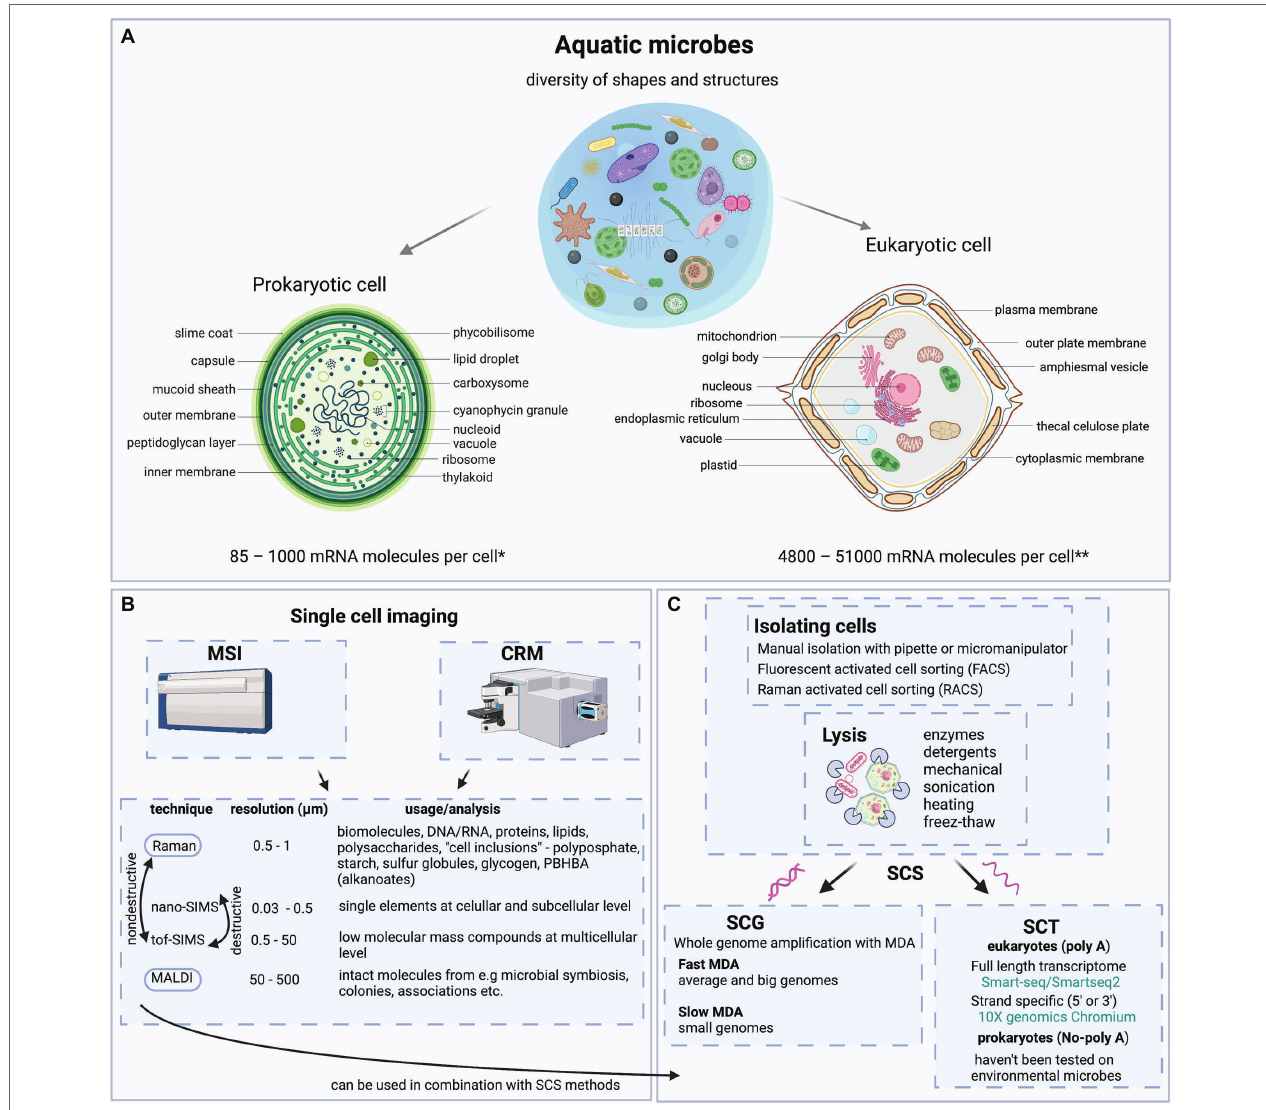
FIGURE 2 | Overview of Aquatic Microbes, MSI and SCS workflows in Aquatic Microbiology. (A) Diversity of shapes and structure present in aquatic microbial cells. Prokaryotic cell architecture is illustrated using unicellular cyanobacteria as an example. Eukaryotic cell architecture is illustrated using a thecate non-flagellated dinoflagellate example. Amounts of mRNA in prokaryotes and eukaryotes are based on estimates. * Based on RNA recovery from natural bacterioplankton communities of coastal waters (Moran et al., 2013 and reference therein). **Based on RNA recovery from culture of haptophyte ( Prymnesium parvum ) and dinoflagellate ( Karlodinium veneficum ) (Liu et al., 2017). (B) Single cell imaging techniques; comparing capabilities of mass spectrometry imaging (MSI) and confocal Raman microspectroscopy (CRM). Techniques are arranged according to spatial resolution and what molecular/cellular structures they can analyze. Raman and MALDI are non-destructive techniques so they could be used in combination with SCS methods. (C) Diversity of shape, size, and structure of microbial cells presents challenges to separation and isolation of cells. Most common ways of isolating cells are presented. Lysis is another problem arising from diverse and thick cell walls. The most common ways to lyse cells are presented. Single cell sequencing techniques, including single cell genomics (SCG), single cell transcriptomics (SCT) and an assortment of protocols and technologies used in SCS methodologies are presented. Most common method for SCG gene amplification in aquatic microbial ecology is with MDA reaction. Depending on genome size and difficulties in cell lysis, different MDA amplification techniques can be applied and optimized (Ciobanu et al., 2022). SCT technologies tested on cultured aquatic microbial eukaryotes include those for full length transcriptome generation (Kolisko et al., 2014; Liu et al., 2017) and those that generate only one side of transcriptome (3’ or 5’ strand specific) (Ma et al., 2021). SCT has not yet been tested on aquatic prokaryotes although available technologies have been tested on other bacterial representatives. Graphics and illustrations made with